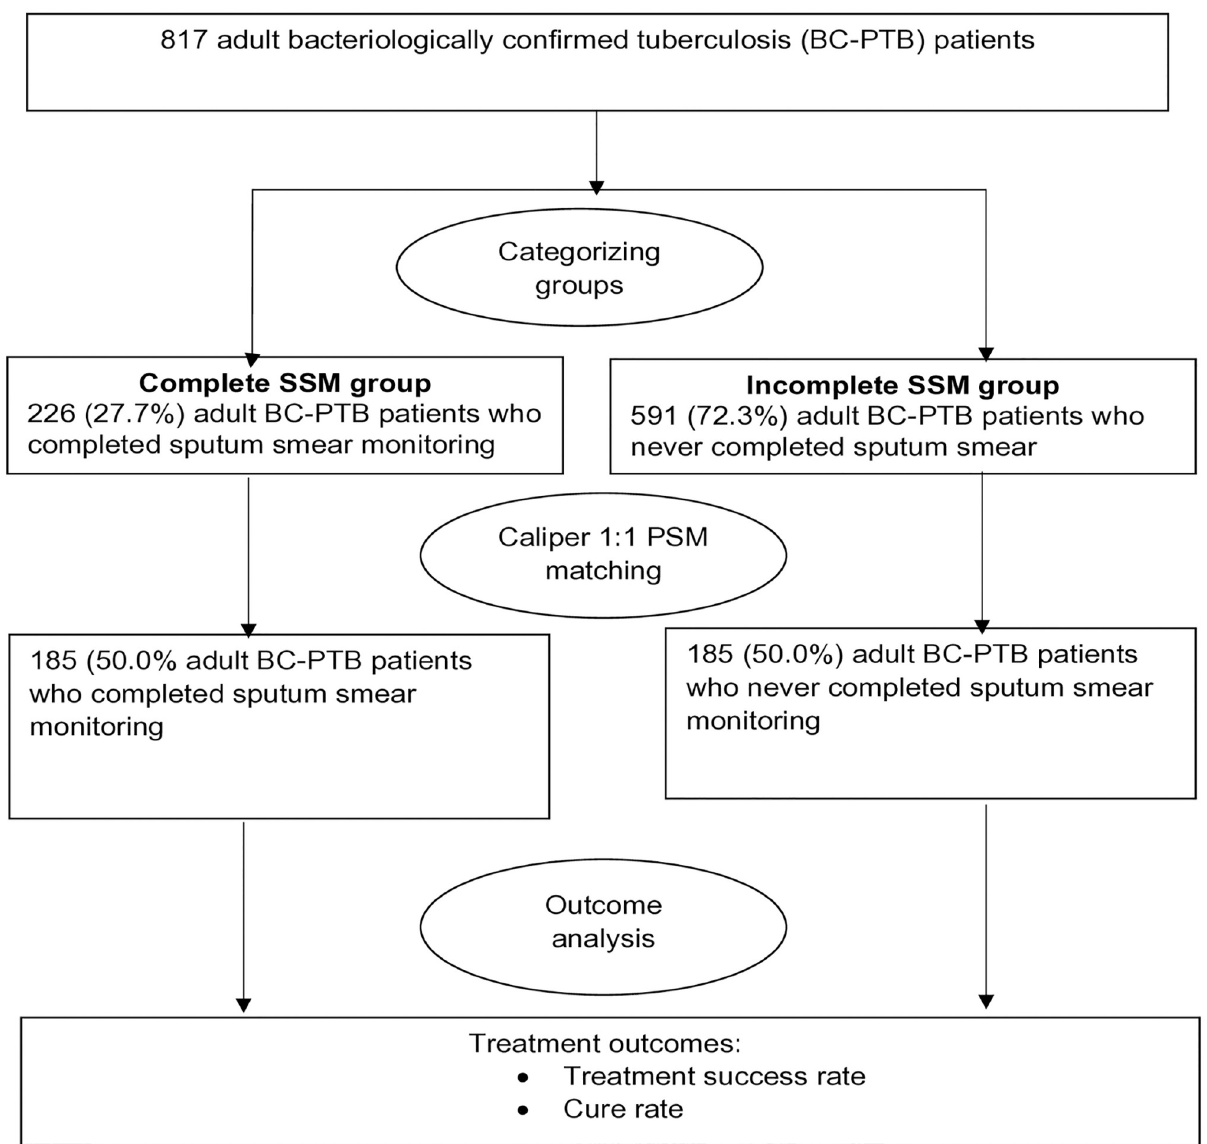
Fig 1. Study profile showing the number of adult bacteriologically confirmed tuberculosis cases before and after propensity score matching, rural Eastern Uganda. https://doi.org/10.1371/journal.pone.0226919.g001 PLOS ONE | https://doi.org/10.1371/journal.pone.0226919 December26,